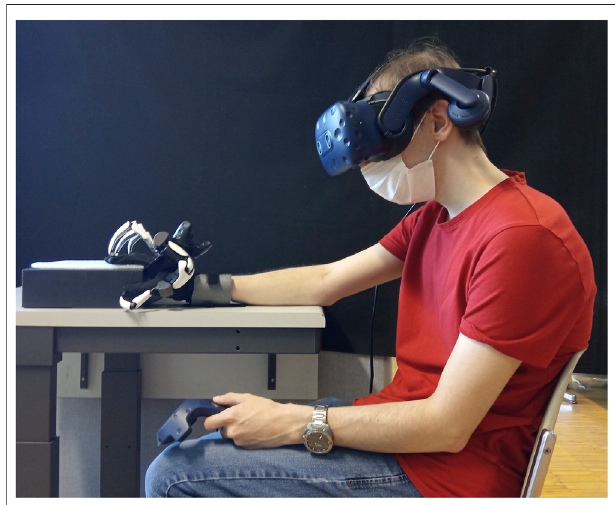
FIGURE 1 | Global view of the experimental setup.